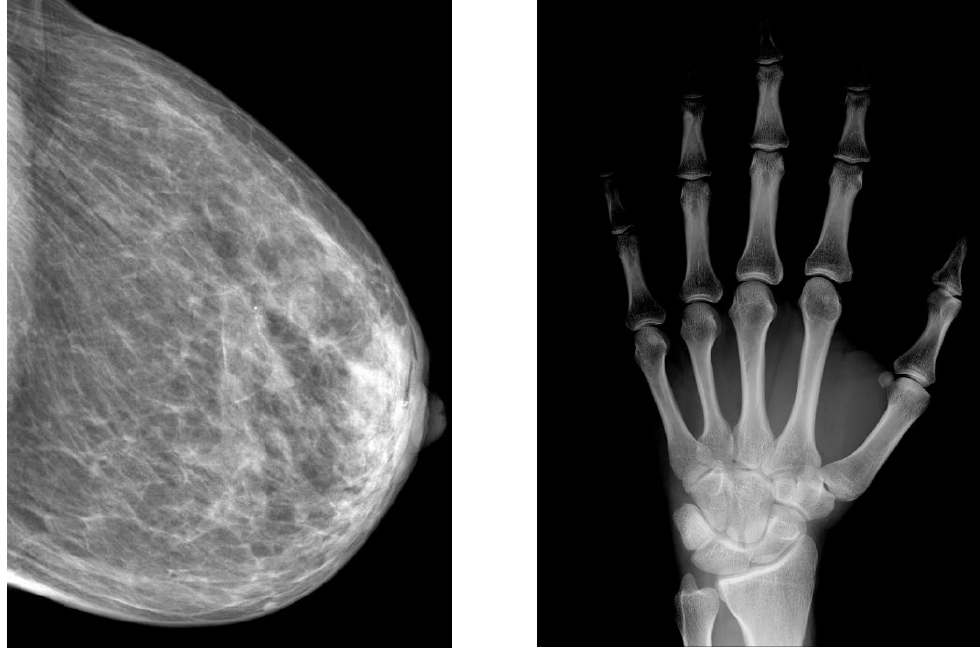
Figure 4. Two typical x-ray images from an a-Se FPXI. Left, a typical x-ray image of a breast. Right, an x-ray image of a